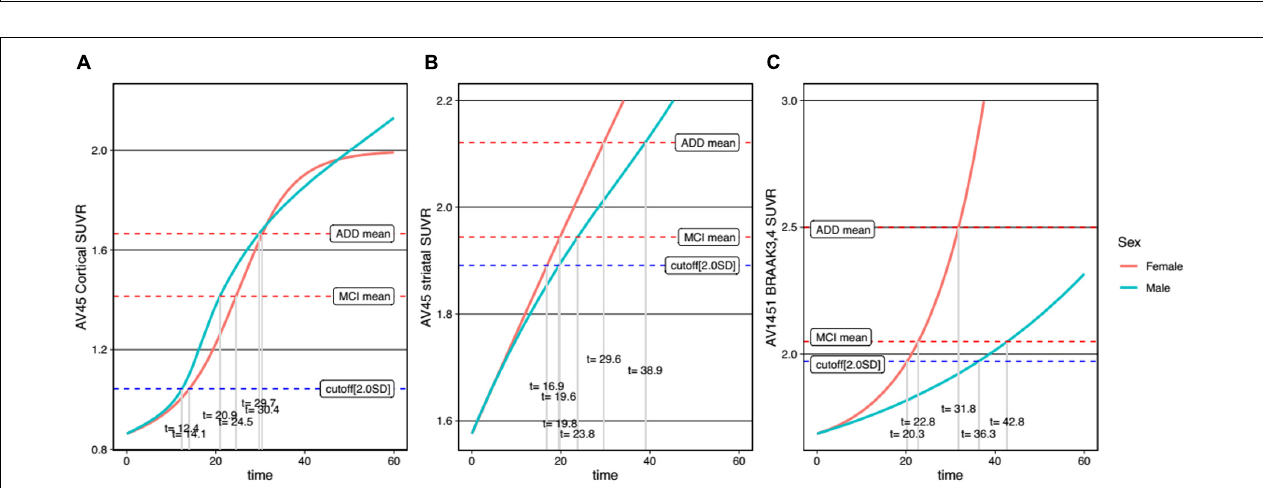
Frontiers in Aging Neuroscience |